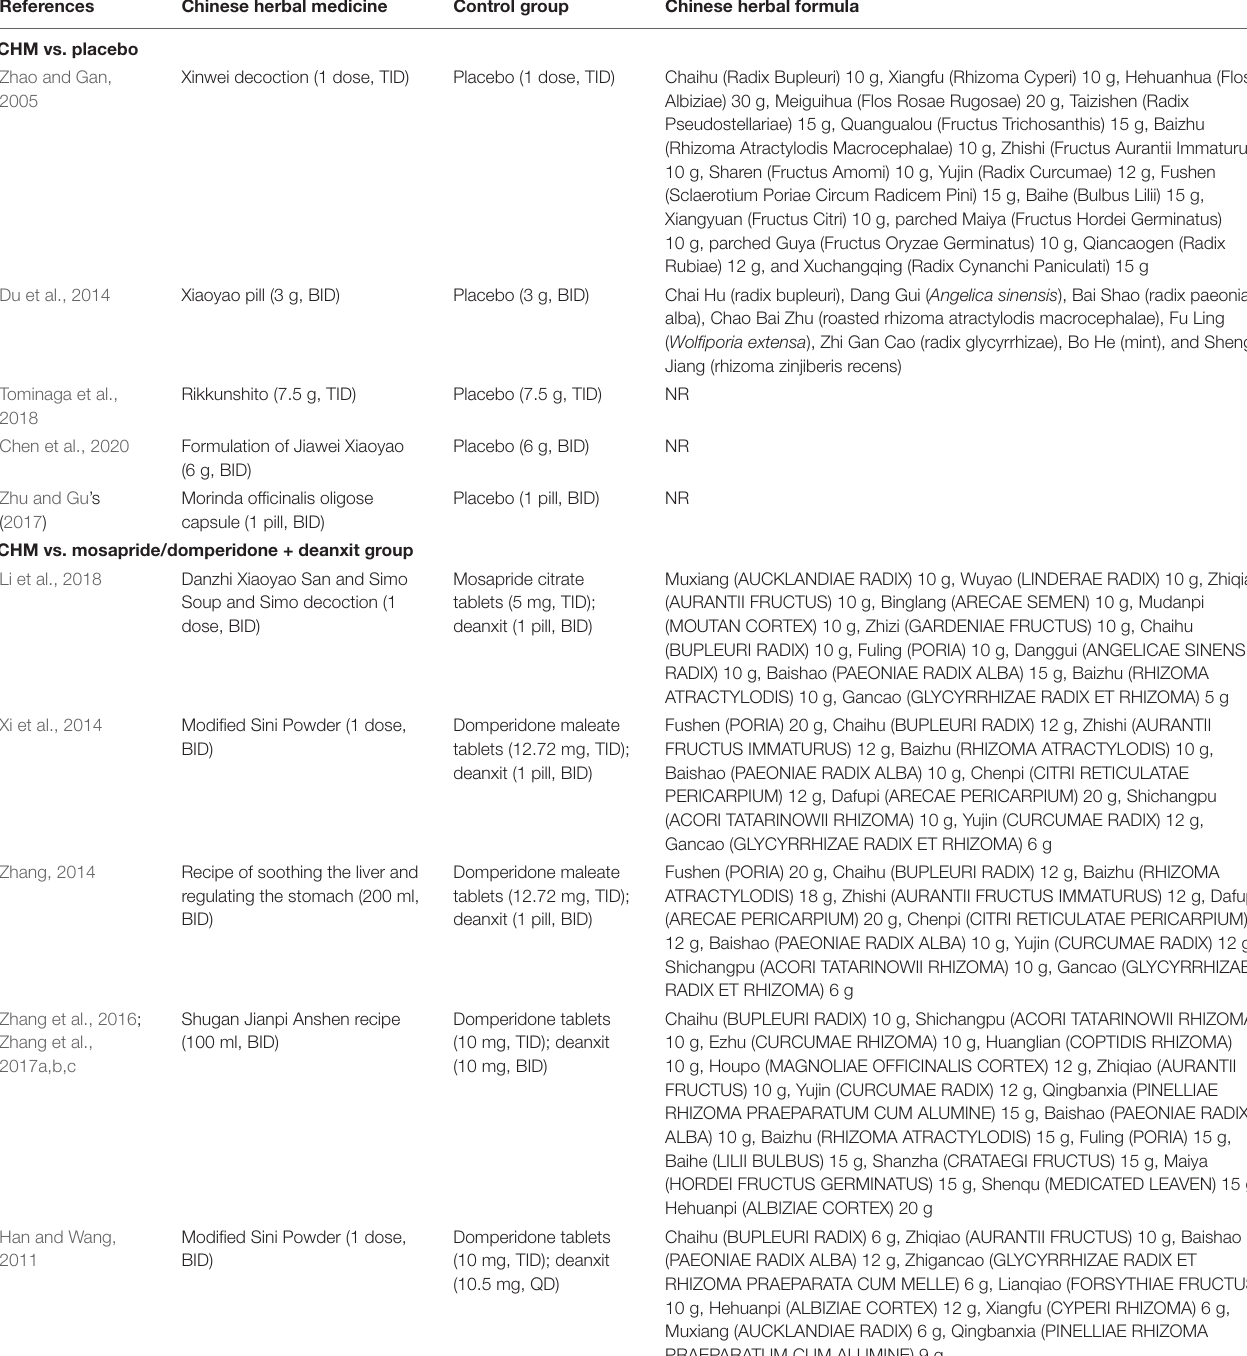
TABLE 2 | Composition of Chinese medicine